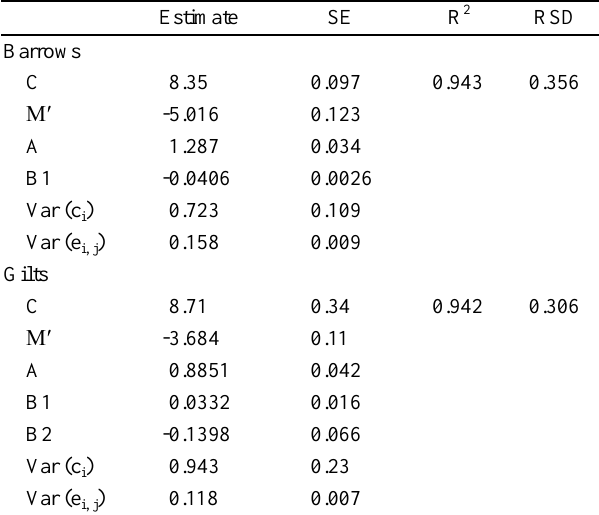
Table 9. Parameters for the Bridges Function fitted to daily NE intake (Mcal/d) a